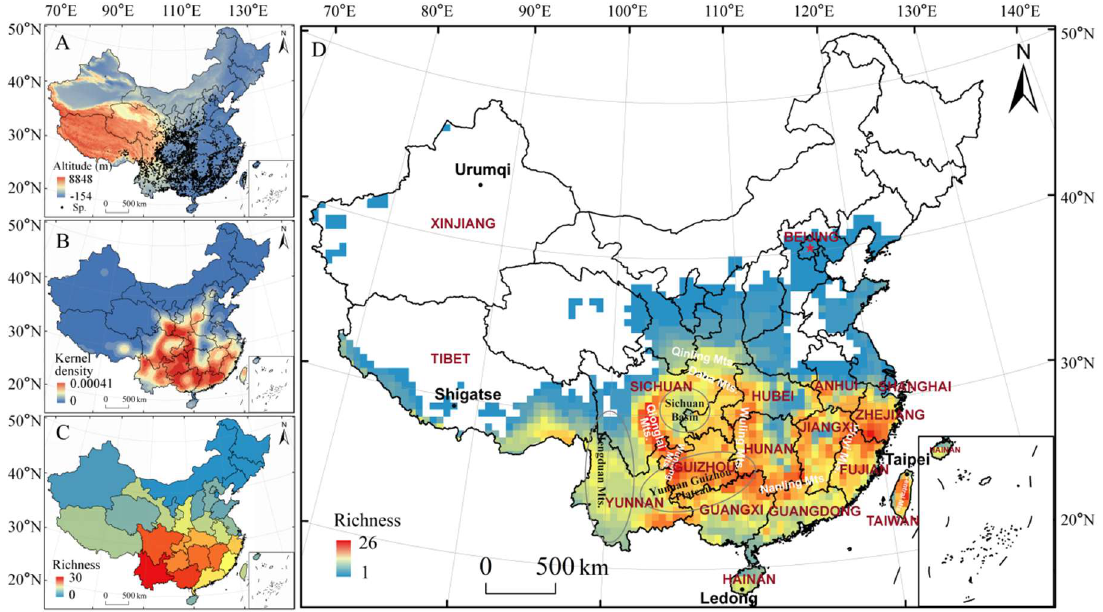
Figure 2. Geographical pattern of hotspots for endemic taxa of Viburnum in China. ( A ) Specimen Collection Patterns; ( B ) Kernel density of specimen collection; ( C ) Species richness at the provincial level; ( D ) Species richness at the 50 × 50 km grids.